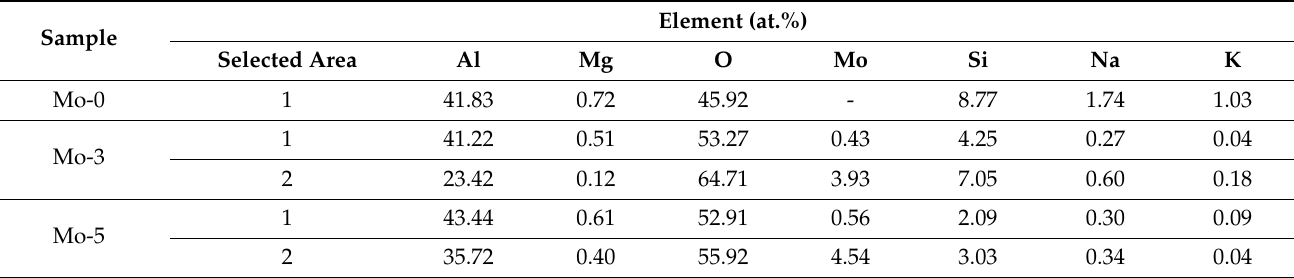
Figure 5. The selected areas from a cross ‐ section of the coatings and micro ‐ pore for EDS analysis: Table 2. EDS analysis results of the coatings.